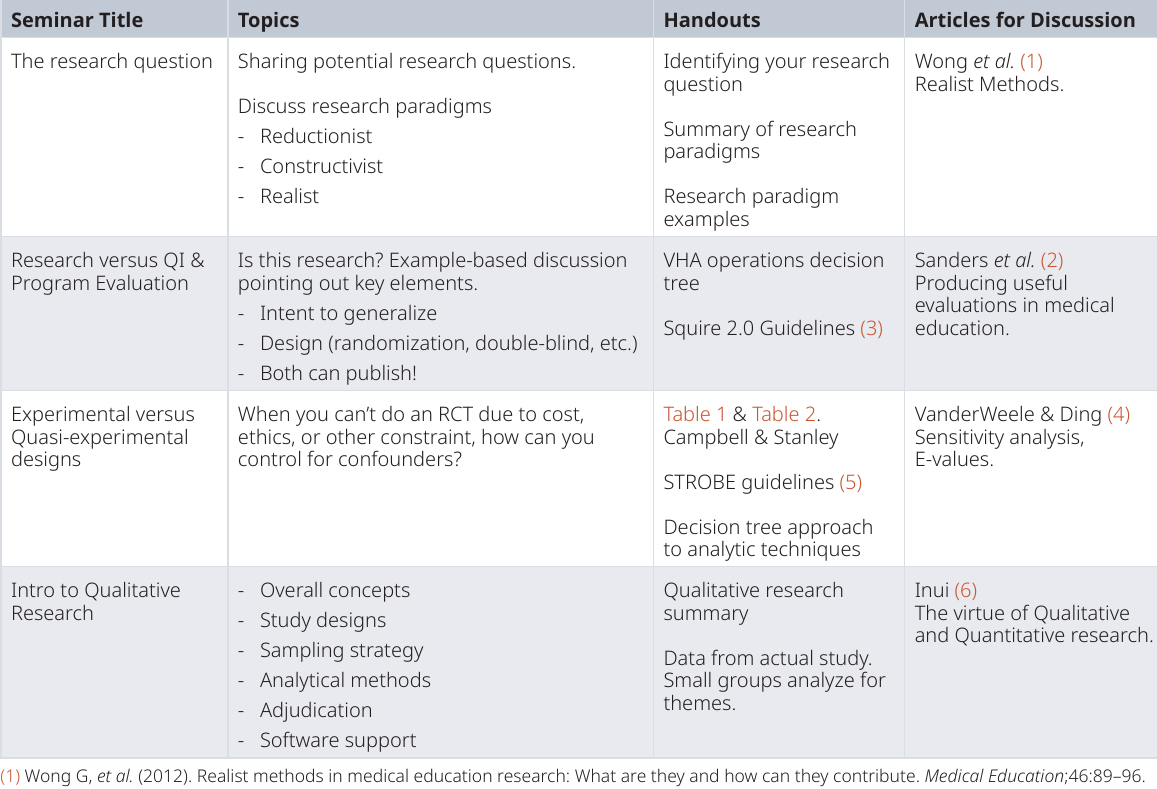
Table 1. Description of the four initial seminars involved in the grant writing program.